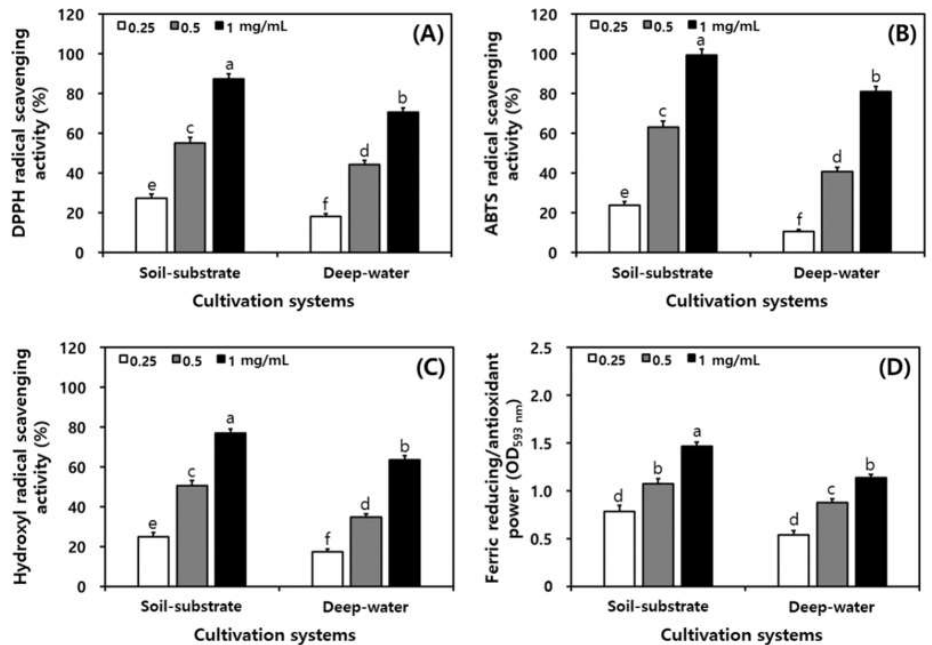
Figure 3. Comparison of antioxidant activity of PGS in different cultivation systems in a plant factory. ( A ) DPPH radical scavenging activity; ( B ) DPPH radical scavenging activity; ( C ) hydroxyl radical scavenging activity; ( D ) ferric reducing/antioxidant power. All values are presented as the mean ± SD of pentaplicate determination. Different letters correspond to the significant differences related to the processing steps using Tukey’s multiple test ( p < 0.05).